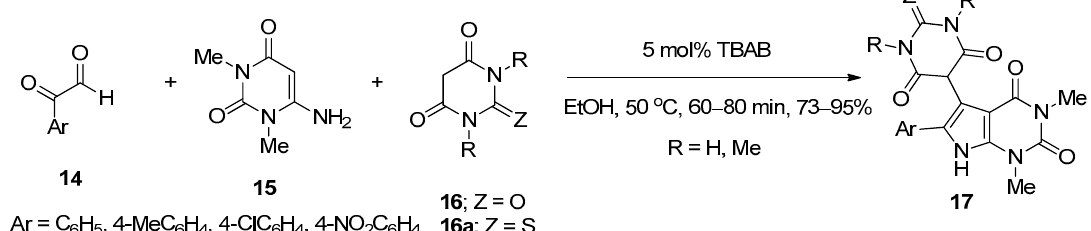
Scheme 6. TBAB-catalyzed synthesis of 1,3-dihydrobenzimidazol-2-ones and 1 H -imidazo[4,5- b ]pyridin-2(3 H )-one under microwave-assisted conditions.